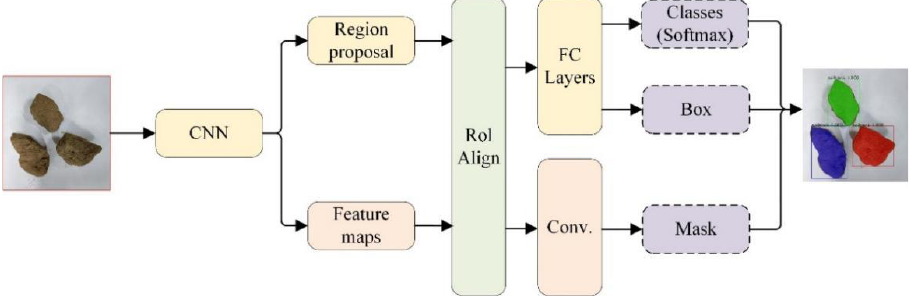
Figure 3. Mask-RCNN overall framework.